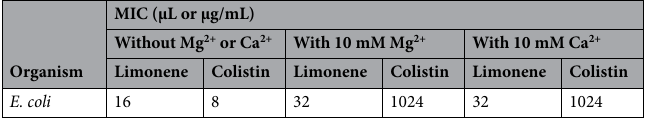
Table 3. Effect of divalent cation salt solutions on the bactericidal activity of Limonene.